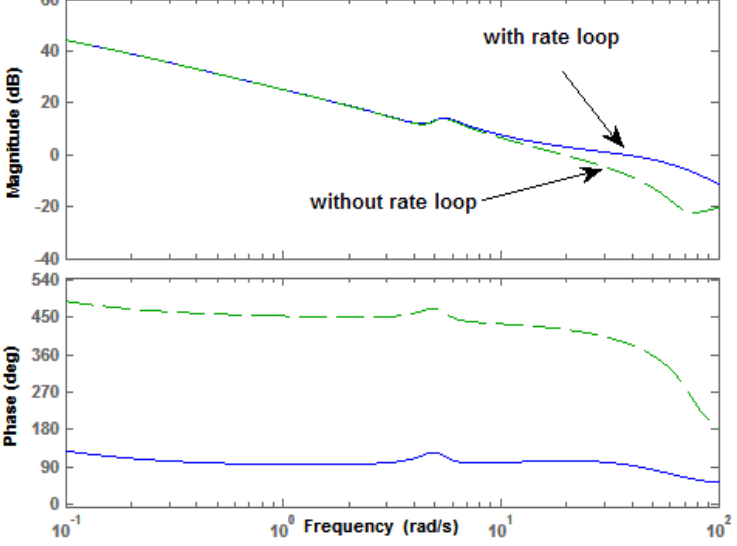
Figure 6. Effect of rate-loop closure in loop transmission of p